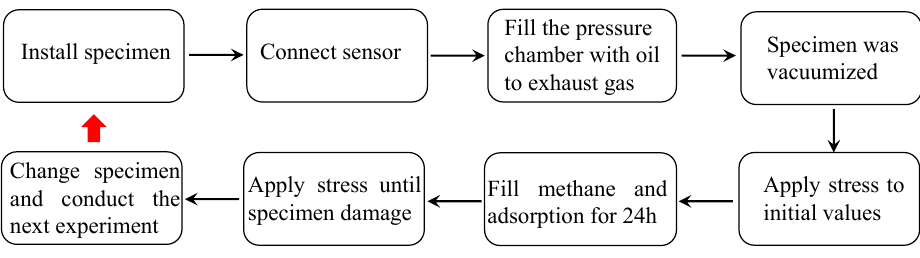
Figure 5. Stress–strain curves of specimens under different test paths. At peak strength, ε 1 and ε 3 are 2.607 and − 1.771 in Test 1; 1.301 and − 1.354 in Test 2; and 0.793 and − 2.186 in Test 3. In Test 1, the axial strain is the largest. In Test 3, the axial strain is the smallest, but the radial strain is the largest. At peak strength, the axial-to- radial strain ratios of the specimens are 1.472, 0.961, and 0.363. The gradual reduction in